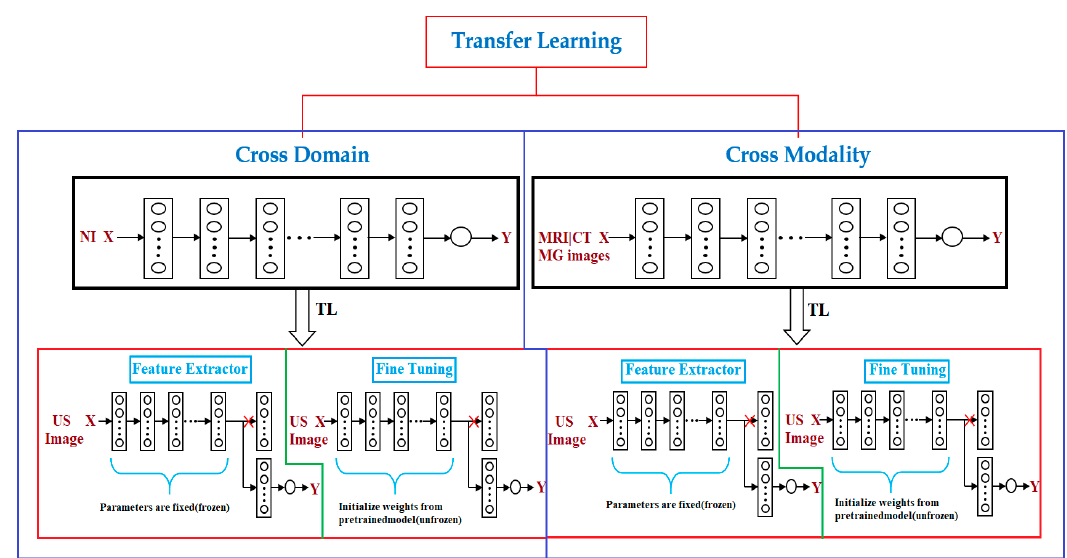
Figure 1. Transfer learning (TL) methods. There are two types of transfer learning used for breast cancer diagnosis via ultrasound imaging, depending on the source of pre-training data: cross-domain (model pre-trained on natural images is used) and cross-modal (model pre-trained on medical images is used). These two transfer learning approaches are feature extractors (convolution layers are used as a frozen feature extractor to match with a new task such as breast cancer classification) and fine-tuning (where instead of freezing convolution layers of the well-trained convolutional neural network (CNN) model, their weights are updated during the training process). X, input; Y, output; NI, natural image; MRI, magnetic resonance imaging; MG, mammography; CT, computed tomography; US,